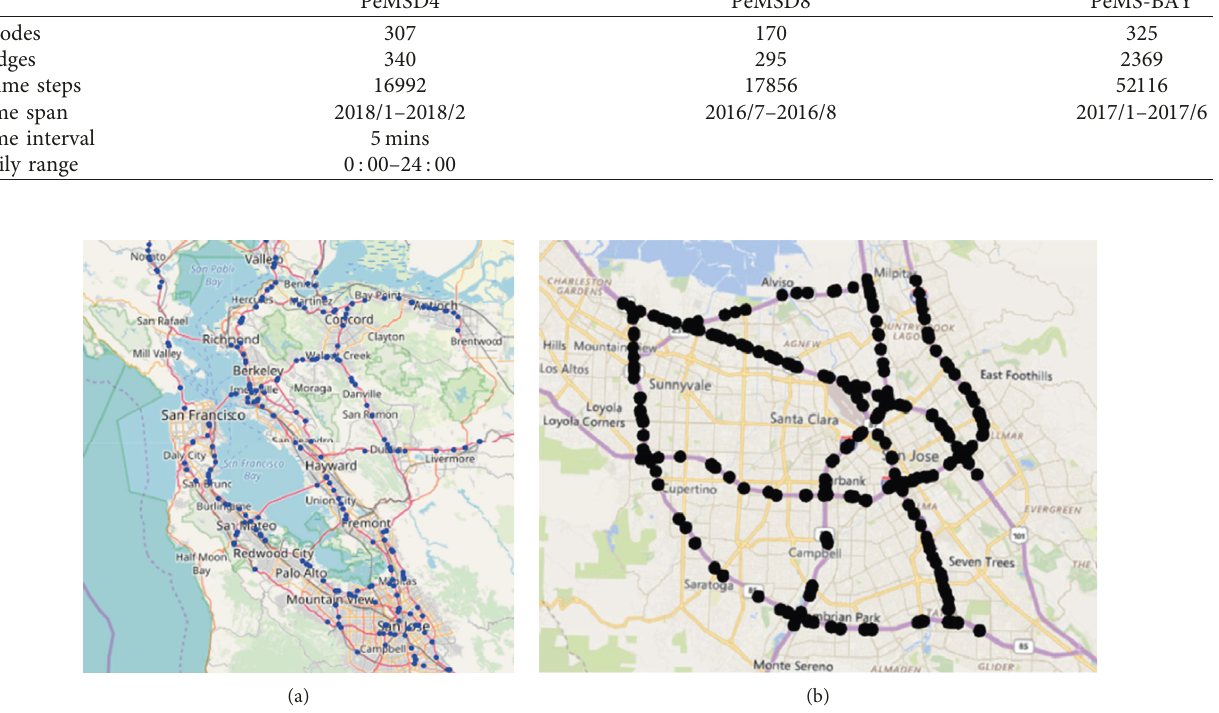
Figure 3: Sensor distribution of (a) PeMSD4 and (b) PeMS-BAY. Table 2: Performance comparison of ST-DWGRU and other approaches on the datasets PeMSD4, PeMSD8, and PeMS-BAY.